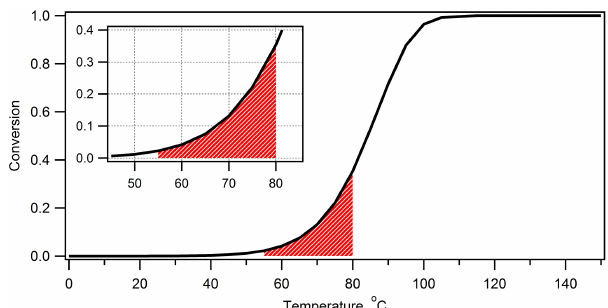
Figure 7. Model of thermal decomposition of PAN to NO 2 with a residence time of 0.96s at temperatures between 0 and 150 ◦ C. Inset is detail of 45 to 85 ◦ C. The red shaded area corresponds to the temperature range of the UV LEDs of a BLC. Kinetic data from IUPAC (Atkinson et al.,